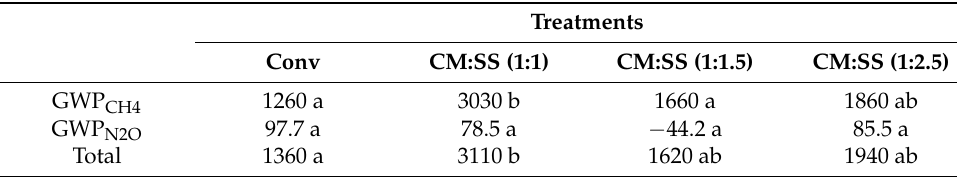
Table 3. Global warming potential of CH 4 (GWP CH4 ) and N 2 O (GWP N2O ) (kg CO eq ha − 1 ) in the pot